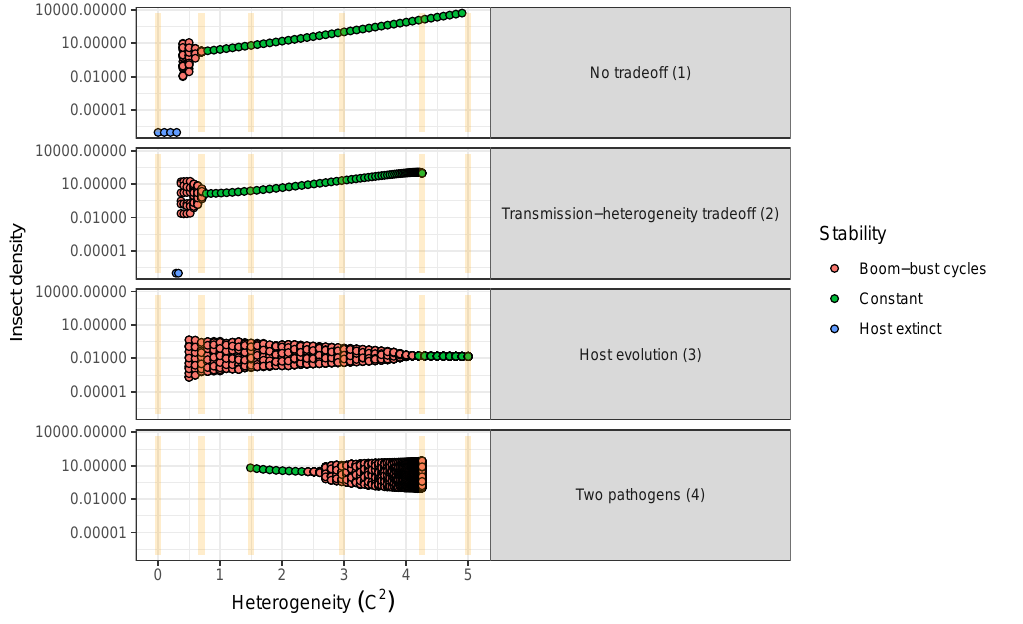
Figure 5. Effects of heterogeneity of transmission and life history tradeoffs on the long-term population dynamics of host insects for four different models. Models are numbered according to Table 1; note that Model 0 (linear transmission) is not included as it does not include heterogeneity of transmission. See Figure 4b for details on models and parameter values. For any given value of C 2 multiple insect densities (dots) occur whenever the insect population cycles through time. Thus, the dot range across the y-axis indicates the cycle amplitudes, whereas the number of dots indicate the frequency of recurring cycle peaks or troughs averaged over a period of 30 generations. Light orange vertical bars indicate the six heterogeneity values plotted in Figure